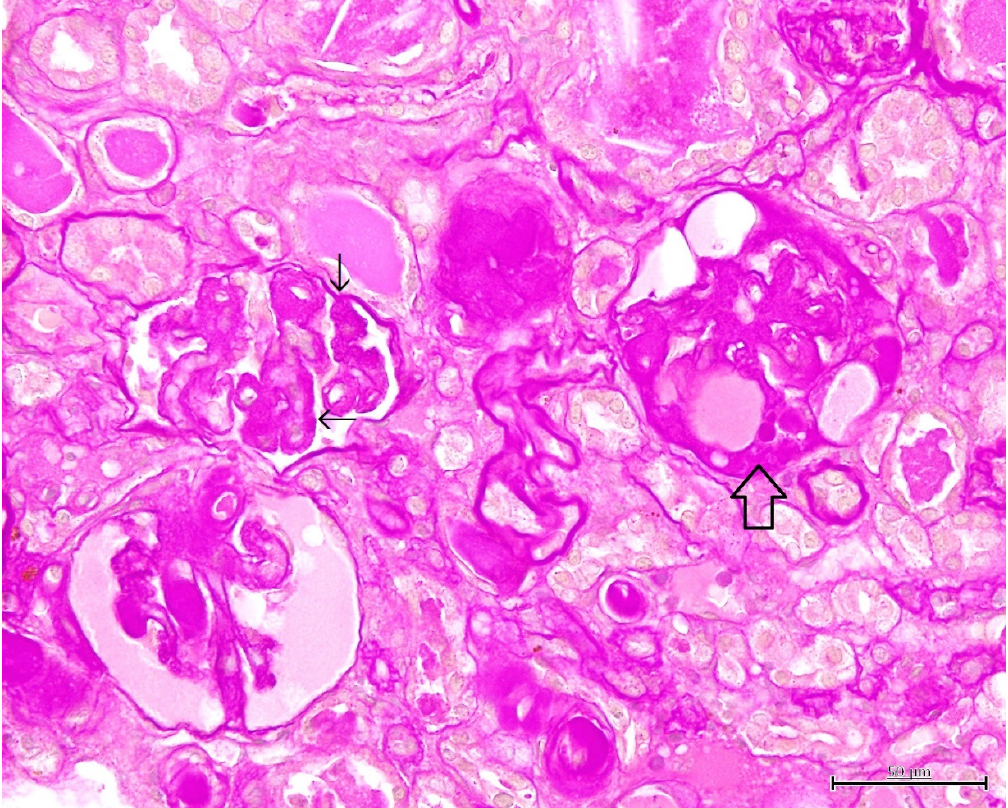
Figure 5. Microscopic finding of polycystic kidney. Dense amorphous substances (open arrow) are deposited in the glomeruli and glomerular capsules. Thickening of basement membrane and hyalinization (thin arrow) are also seen. PAS stain. ×400, Bar = 50 μ m.